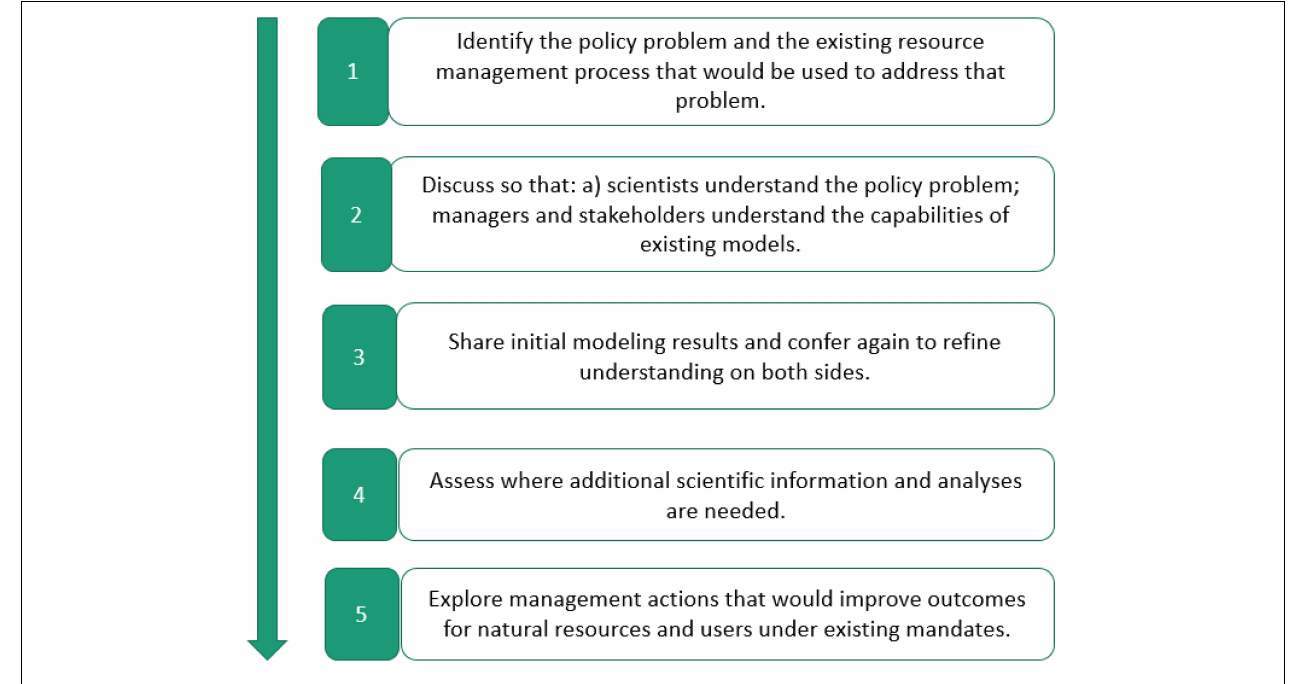
FIGURE 1 | Interactive Process for Developing and Using Ecosystem Models in Policymaking.